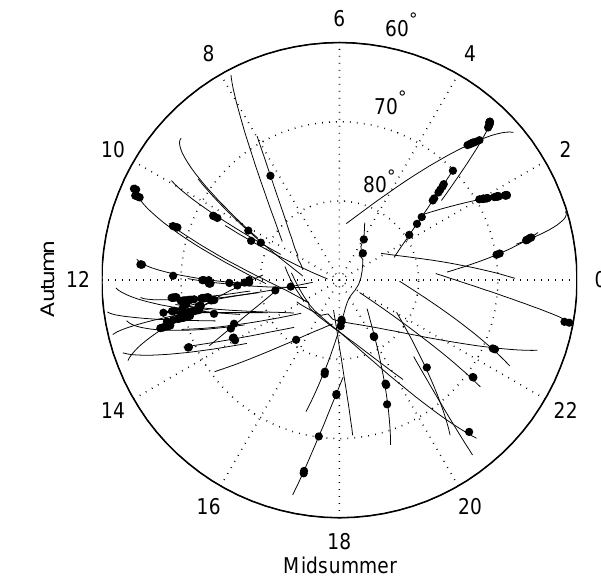
Fig. 5. Diagram with Magnetic Local Time (MLT) and invariant latitude, showing the investigated data intervals (the lines) and the location of the identified LHCs (the dots) in the Cluster data set. The total number of identified LHCs is 535, so many of the dots in the figure overlap. The altitudes of the orbits are shown in Fig.